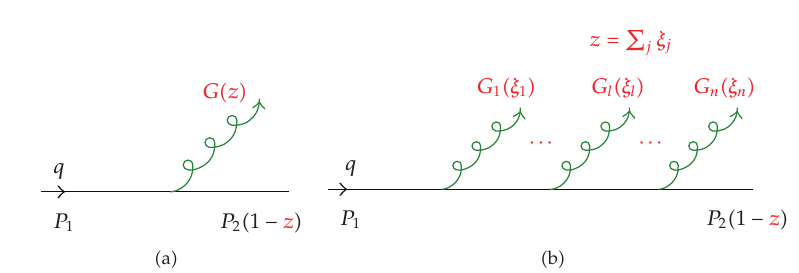
Figure 1: In (cid:3) a (cid:4) , we show the usual process q → q (cid:3) 1 − z (cid:4) (cid:8) G (cid:3) z (cid:4) ; in (cid:3) b (cid:4) , we show its multiple gluon improvement q → q (cid:3) 1 − z (cid:4) (cid:8) G 1 (cid:3) ξ 1 (cid:4) (cid:8) ··· (cid:8) G n (cid:3) ξ n (cid:4) , z (cid:7)